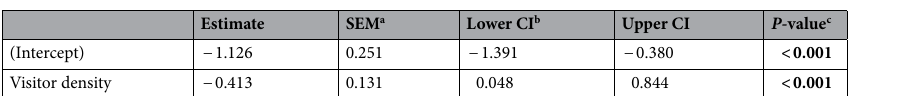
Table 4. Effect of visitor density on social-playing behavior of gibbons (model 2b). *Visitor density (original mean ± SD = 3.37 ± 5.91). a SEM standard error of the mean. b CI confidence interval. c P -values in bold are